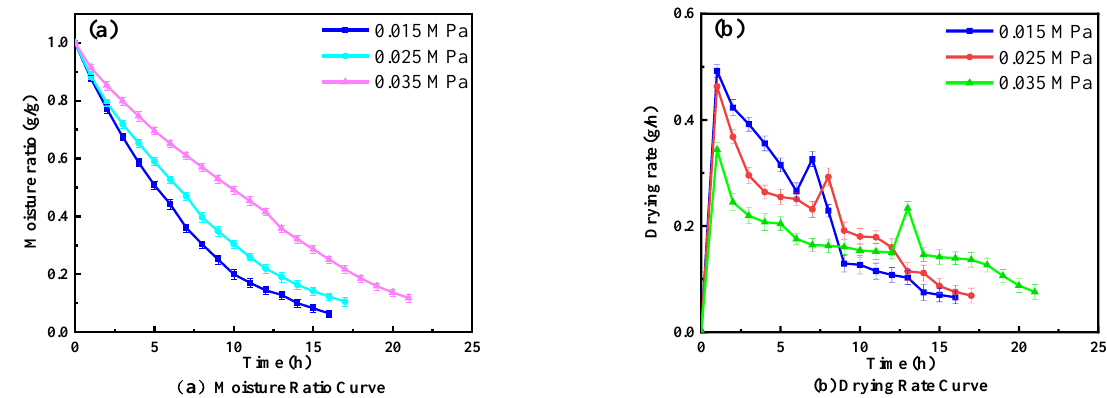
Figure 3. Effect of vacuum degree on combined drying characteristics.